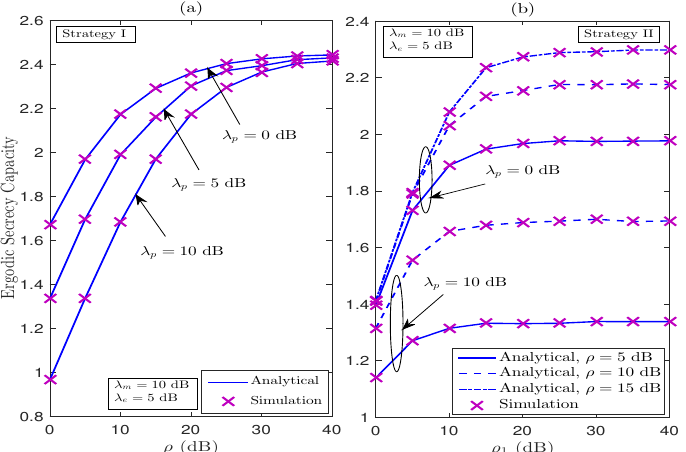
Figure 10. Impact of maximum tolerable interference level ( ρ = I P / N 0 ) and maximum transmit power constraint ( ρ 1 = Q / N 0 ) on the ESC performance.